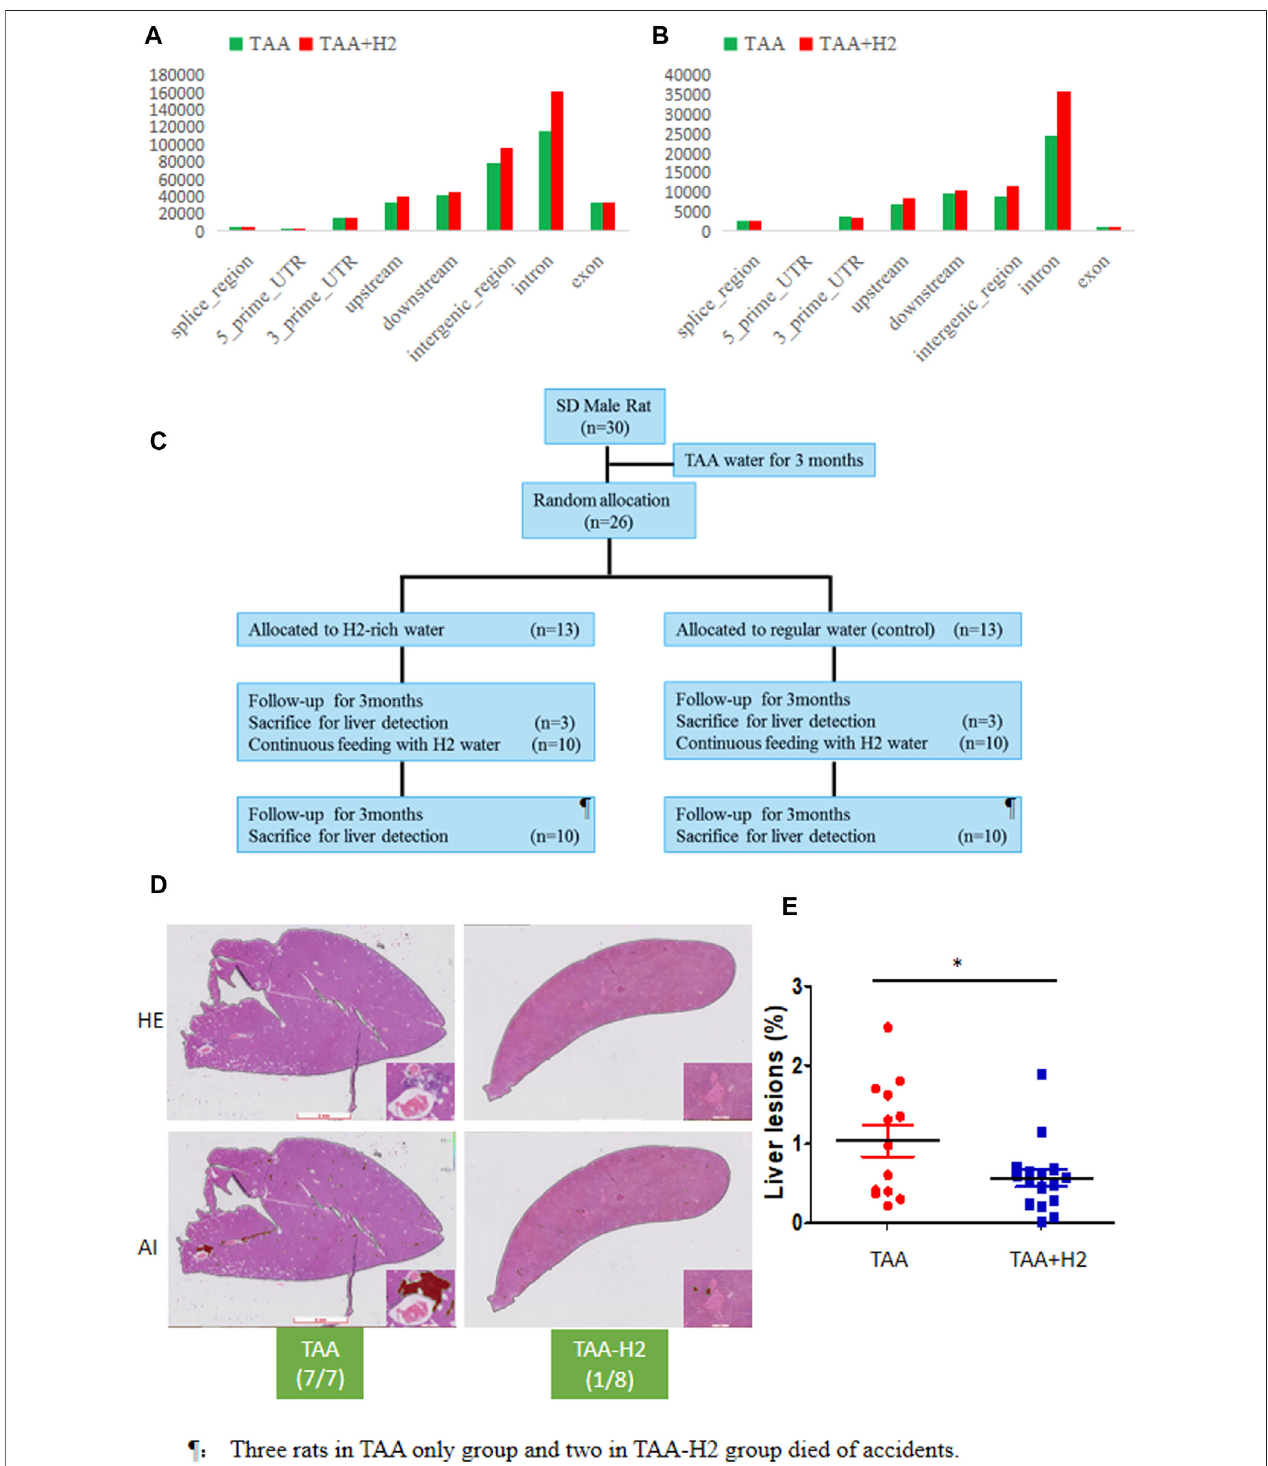
FIGURE5| Long-termuseofH 2 -richwaterinterruptstheTAA-initiatedcholangio fi brosis. (A,B) RNA-seqshowedthenumberofSNP (A) anddeletion/insertion (B) intheliverlesionsfromtheTAAandTAA+H 2 groups. (B) Anexperimental fl owchartwasdesignedtoassesswhethermolecularhydrogencouldinterrupttheprocession of cholangio fi brosis. (C) All rats developed cholangio fi brosis or suspicious cholangio fi brosis in TAA-pretreated rats without following treatment, while only one rat developed cholangio fi brosis if treated with H 2 -rich water. (D) The ratio of liver lesions determined by the AI algorithm in two groups. * p < 0.05.